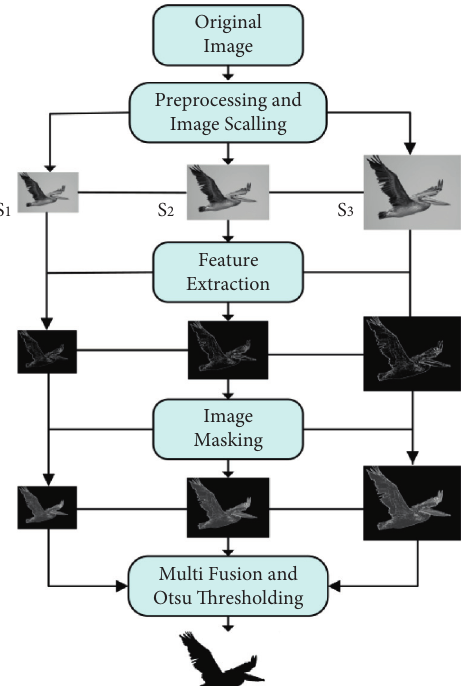
Figure 1: Flow diagram of the proposed method.